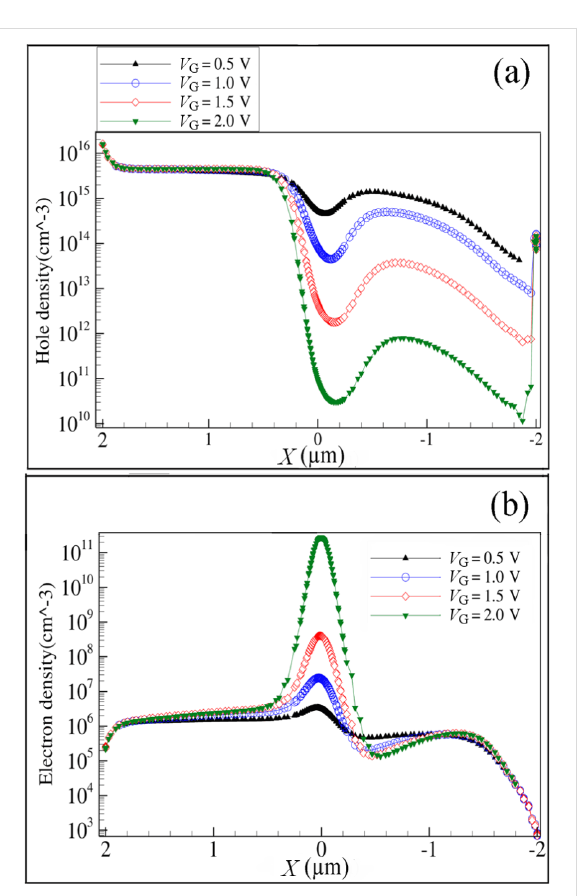
Figure 6: (a) Hole density and (b) electron density distribution as a function of position along a horizontal cross section, at four different gate voltages (0.5, 1.0, 1.5, 2.0 V), V DS = − 1.0